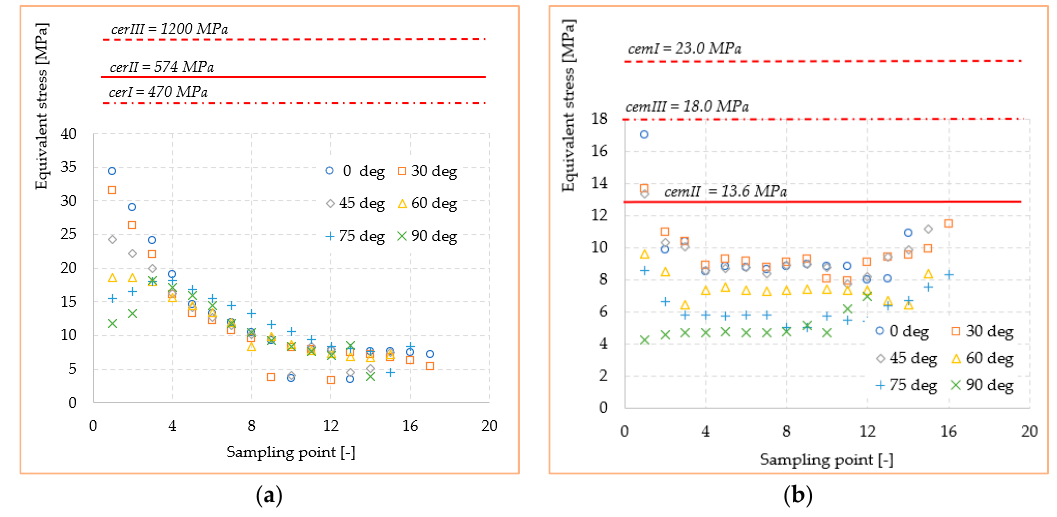
Figure 10. Mechanical strength of dental materials and equivalent stresses recorded at interface: ( a ) ceramic; ( b ) adhesive cement.